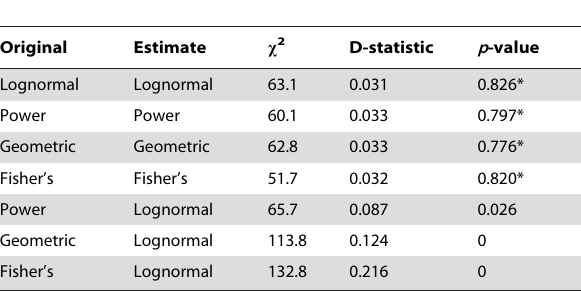
Table 1. Evaluation of distributions that were fit to simulated GC-TRFLP of artificial communities when the original distributions of those communities were known.